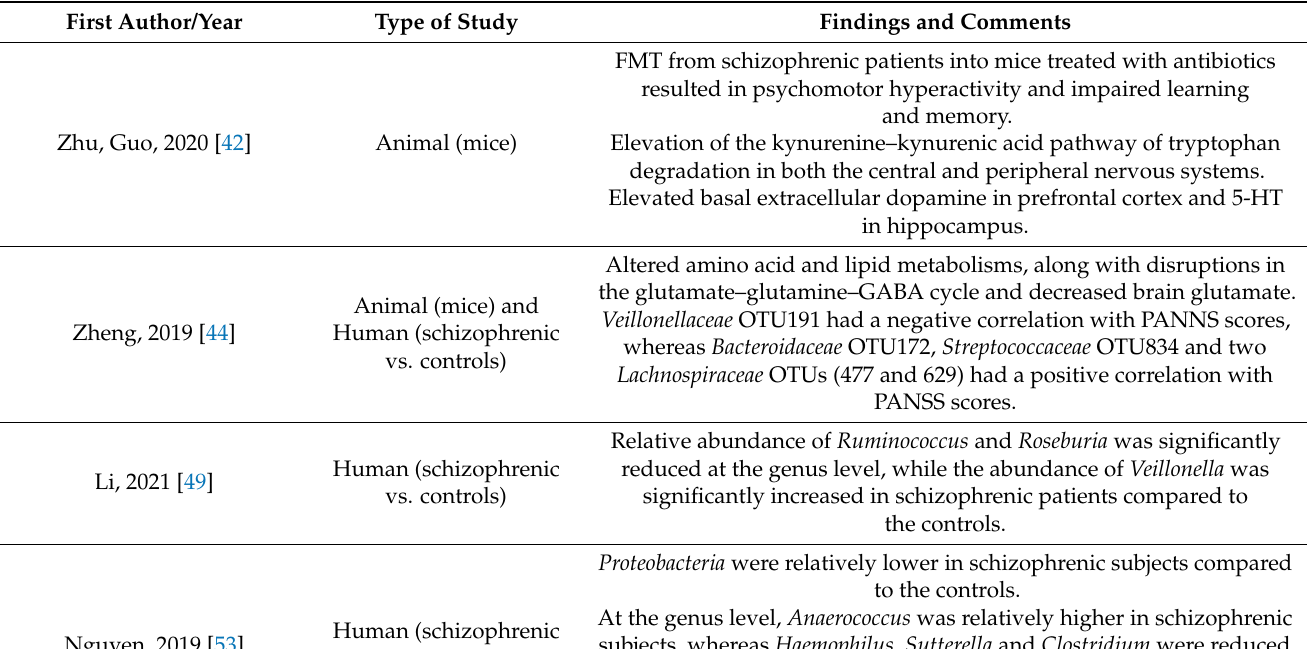
Table 2. A summary of the key experimental/animal studies included in this